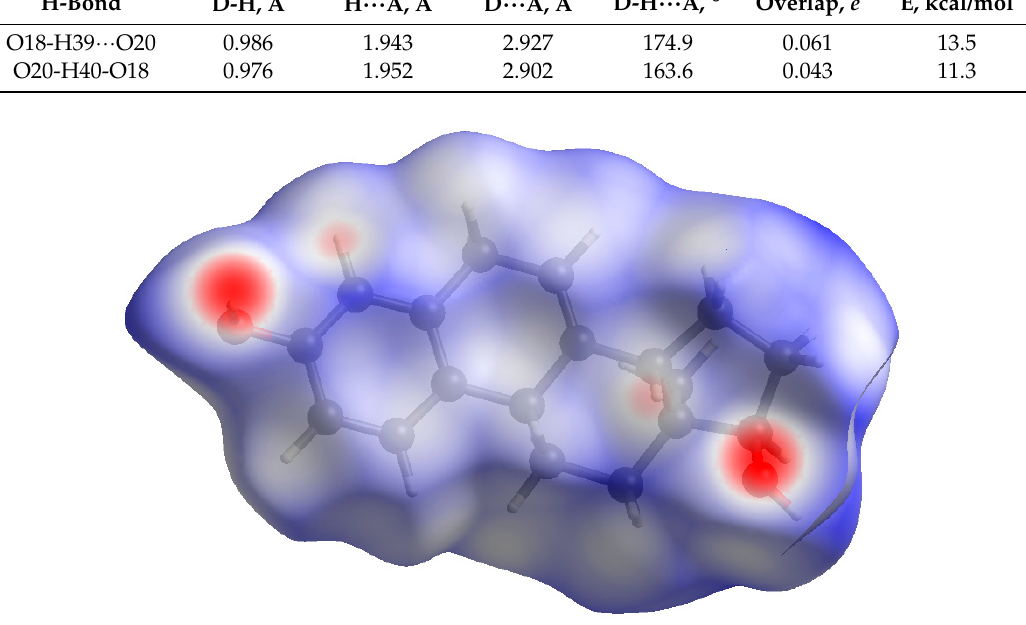
Figure 9. Hirshfeld surface of 17 α -dihydroequilin. Intermolecular contacts longer than the sums of the van der Waals radii are colored blue, and contacts shorter than the sums of the radii are colored red. Contacts equal to the sums of radii are white.